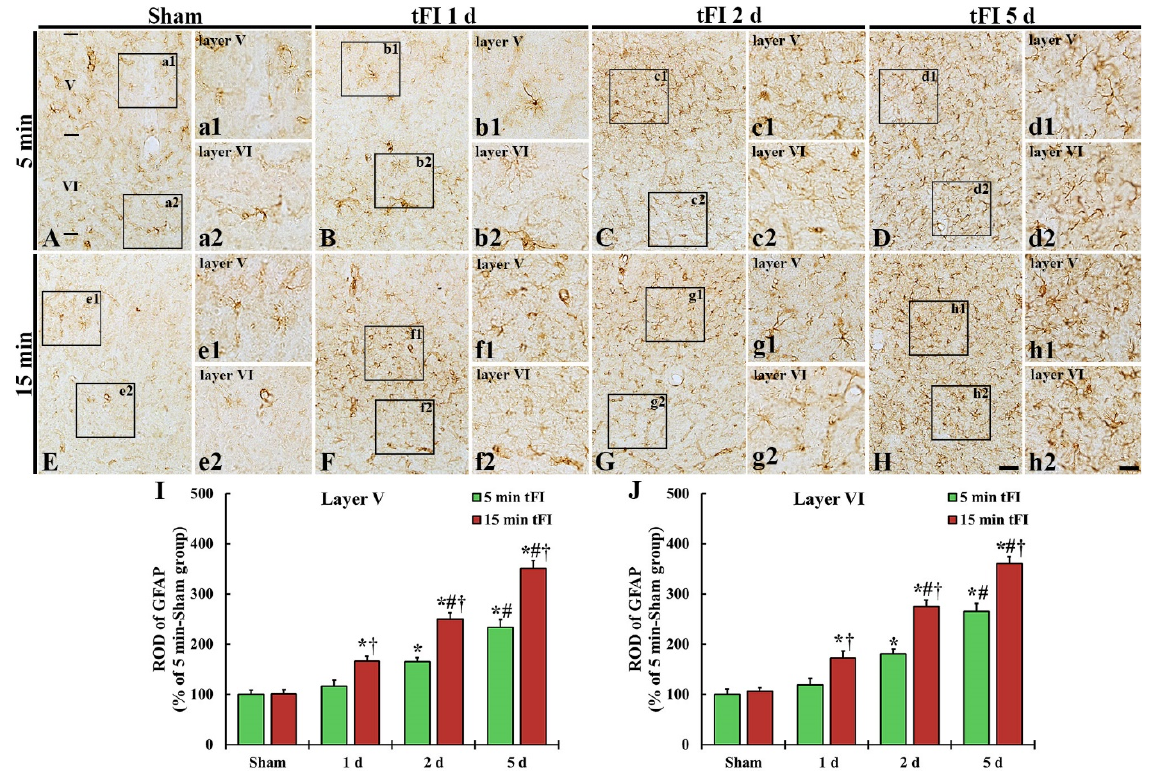
Figure 4. ( A – H ) GFAP immunohistochemistry in layers V and VI of the motor cortex in the mild sham ( A , a1 , a2 ), mild tFI ( B – D , b1 – d1 , b2 – d2 ), severe sham ( E , e1 , e2 ), and severe tFI ( F – H , f1 – h2 , f2 – h2 ) groups on day 1 ( B , b1 , b2 , F , f1 , f2 ), day 2 ( C , c1 , c2 , G , g1 , g2 ) and day 5 ( D , d1 , d2 , H , h1 , h2 ) after tFI.